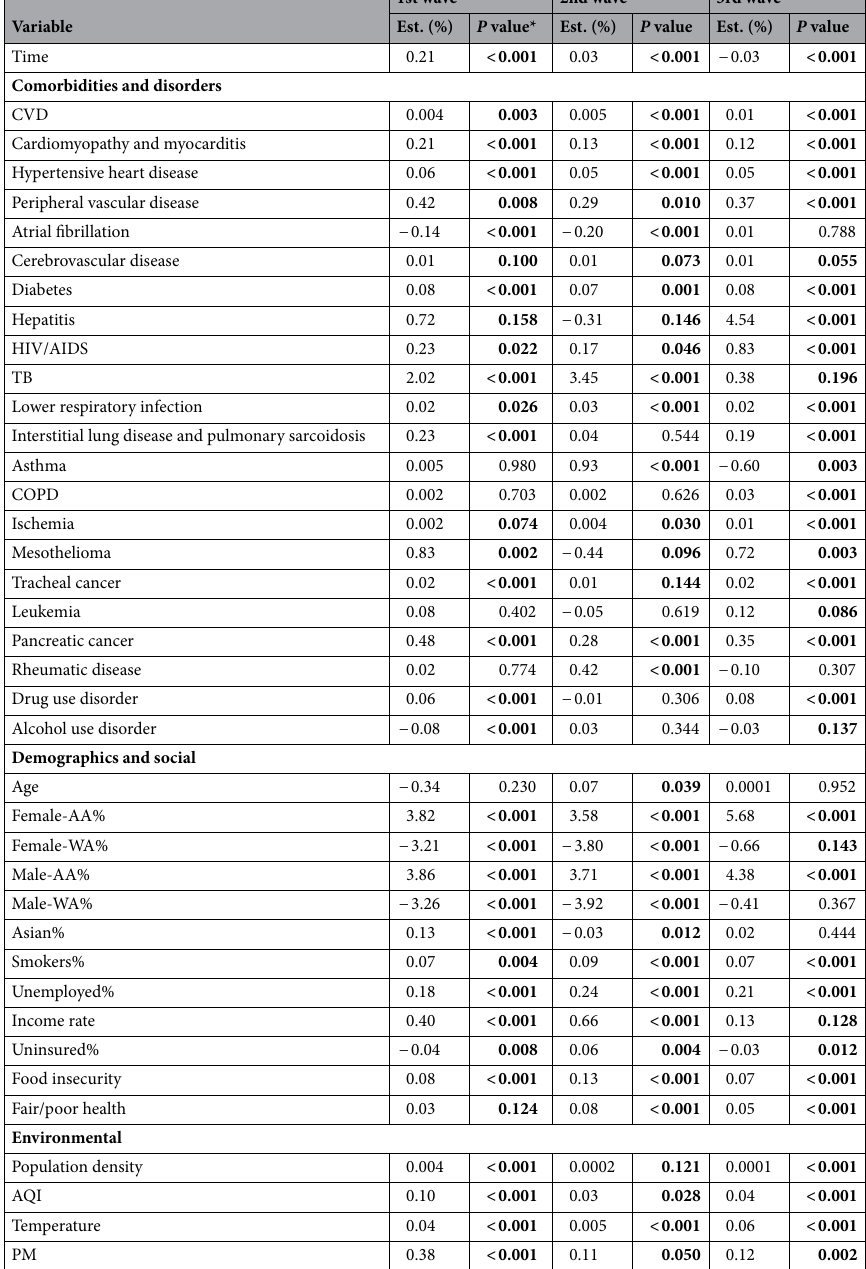
Table 2. Univariate GEE variable selection results. COVID-19 MIR risk factors based on univariate longitudinal GEE models (Mar 25 to Nov 12, 2020, USA). * P value < 0.2 is considered as significant. Bold values are statistically significant for P <